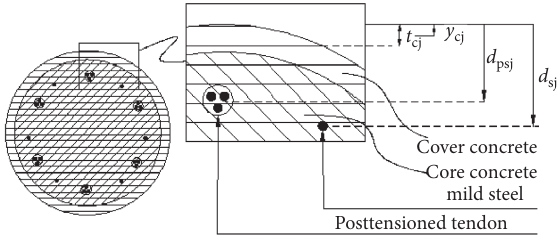
Figure 11: Section